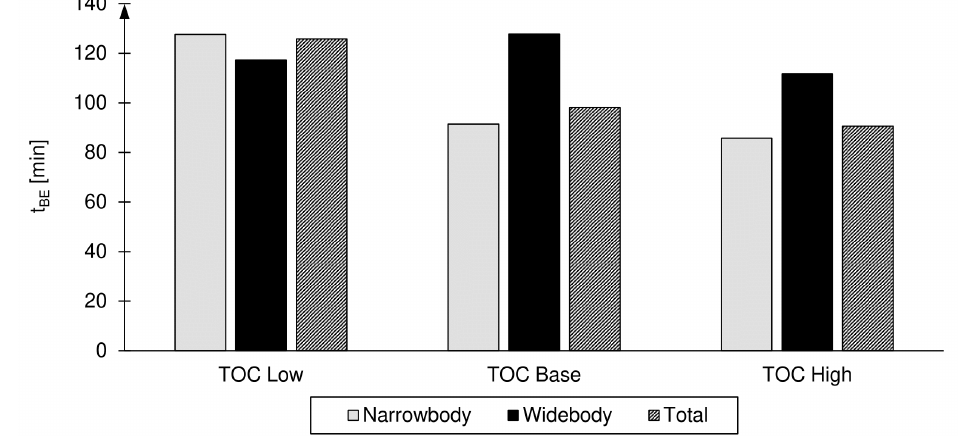
Figure 8. Minimum required delay for a profitability of cancelling the flight ( CANCEL ) due to delay and too many missed connections t BE